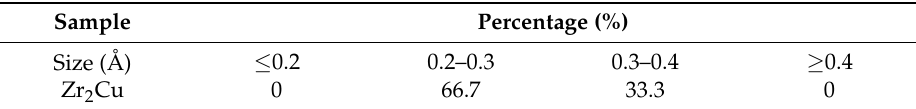
Table 1. Intrinsic voids calculated in a Zr 2 Cu tetragonal phase.